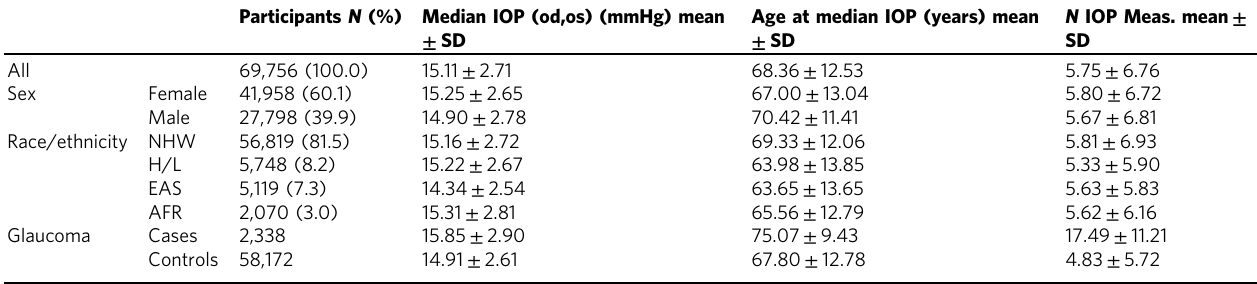
Table 1 Characteristics of GERA subjects with intraocular pressure measurements by sex, and race/ethnicity group